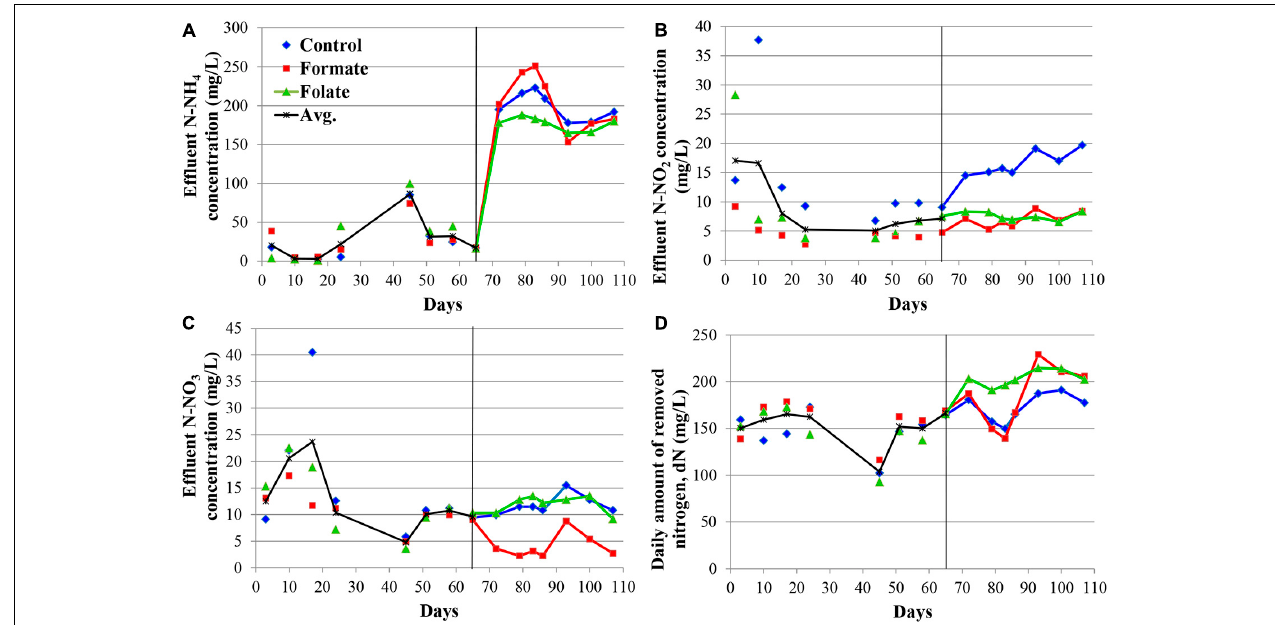
FIGURE 2 | Dynamics of the concentrations of nitrogen compounds in the effluent during the first run of the reactors (milligrams per liter): concentrations of N–NH 4 (A) , N–NO 2 (B) , N–NO 3 (C) , and daily amount of removed nitrogen (dN) (D) . A black vertical line separates periods before and after the additives supplied and the ammonium load increased. The data for each reactor are presented as colored dots and lines; a black curve (avg., average) reflects the values averaged for all three